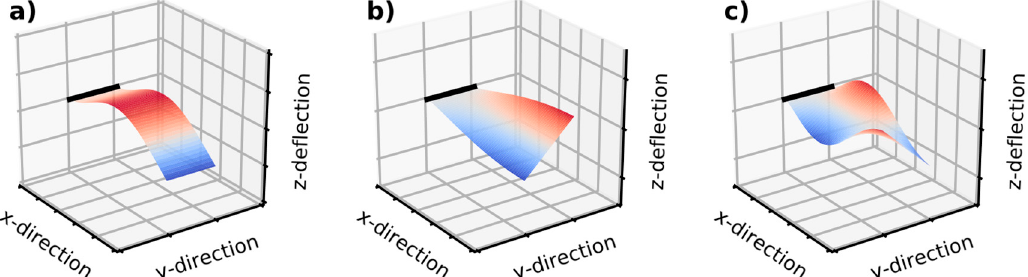
Figure 1. Dynamic ( a ) 10-, ( b ) 01- and ( c ) 11-eigenmodes of a cantilever which is clamped at the side marked by the solid black line. The color coding corresponds to the normalized deflection in z- direction. The modes have been obtained numerically using the finite element package FEniCS [3]. We assume a rectangular cantilever geometry with a length of 2500 µm, a width of 518 µm and a thickness of 20 µm. The material is silicon with a Young’s modulus of 170 GPa and a Poisson’s ratio of 0.28.